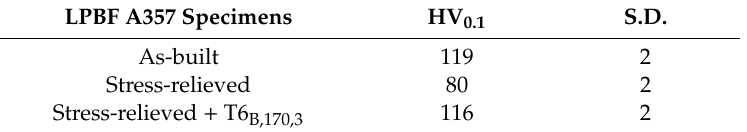
Table 3. A357 micro-hardness mean values for samples in di ff erent conditions.